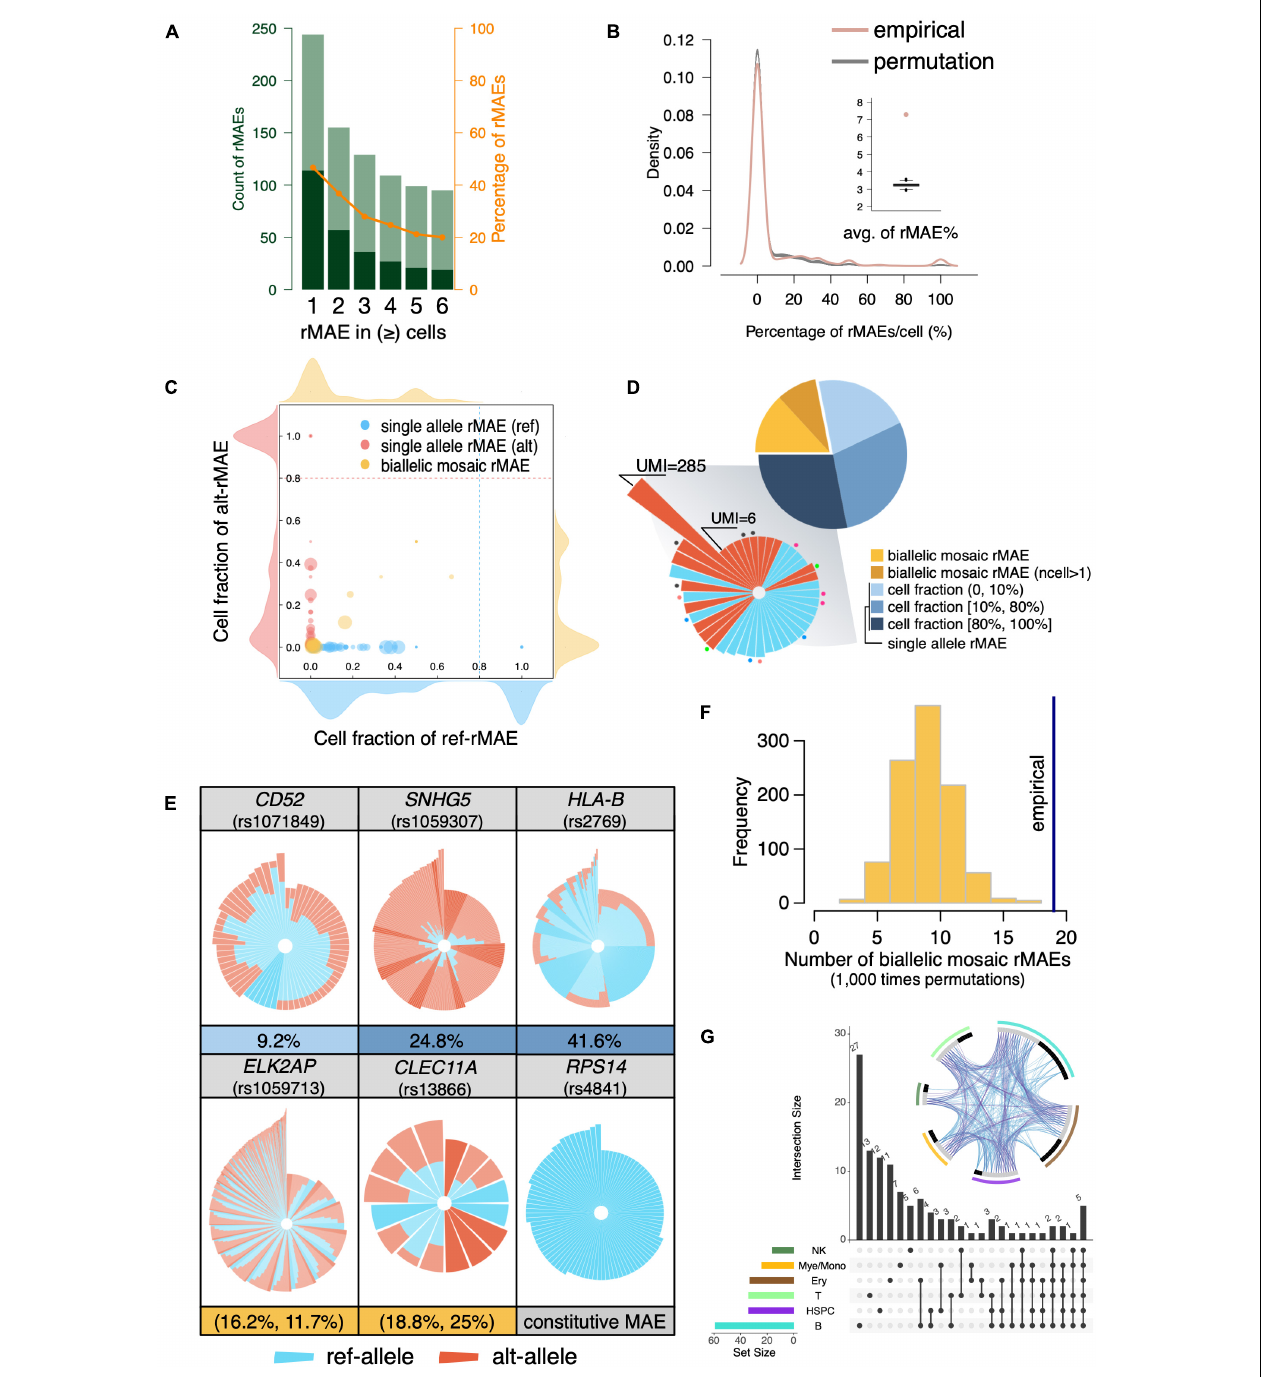
FIGURE 3 | Identification of rMAEs and their features. (A) The identified rMAEs with different thresholds of the observed number of cells. The non-rMAEs and rMAEs are represented by olive and dark green, respectively. The orange line shows the percentage of rMAEs in the analyzed SNVs. (B) The percentage of rMAEs per cell (red), comparing with permutations of alleles (gray). The inset shows the average of the percentages of rMAEs per cell. (C) The rMAEs, including single-allele rMAE (red/blue) and biallelic mosaic rMAE (yellow), are detected in different fractions of cells. The density plots around the scatter plot show the density of rMAEs of different cell fractions with the corresponding allele. (D) The pie chart shows the fractions of different types of rMAEs. The single-allele rMAEs of high cell fraction are shown in circular stacked bars in the shadowed sector. Each bar represents a cell with stacked UMI counts (log 10 ) of ref-allele (blue) and alt-allele (red) of a rMAE. The dots with the same color indicate the bars (cells) of the same rMAE, while bars without a dot mean that they are of different rMAEs. (E) Circular stacked profile of several rMAEs at the single-cell level. Each bar represents a cell with stacked UMI counts (log 10 ) of ref-allele (blue) and alt-allele (red). Cells are ordered by the